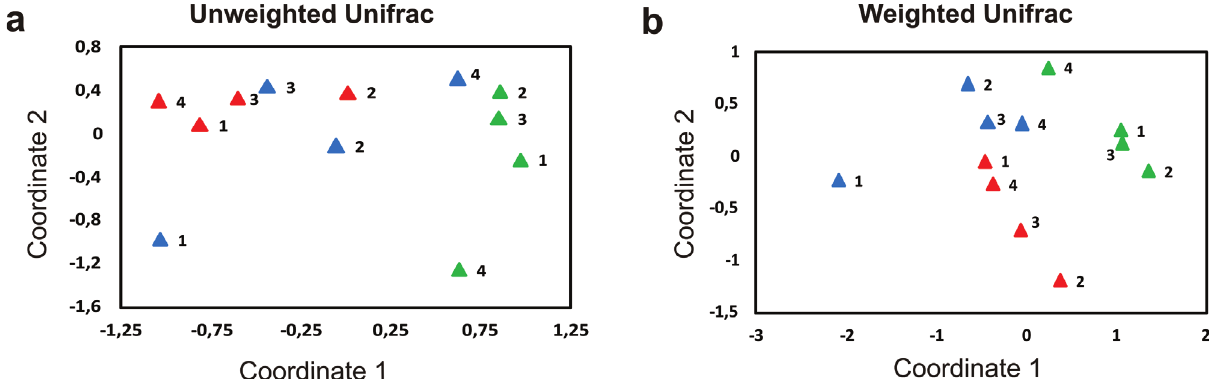
Figure 5 - Non-metric multidimensional scaling (NMDS) clustering using UniFrac distances for bacterial data of coffee genotypes. UniFrac is a distance measure used for comparing biological communities’ information on the relative relatedness of community members by incorporating phylogenetic dis- tances. a) Unweighted (qualitative analysis using presence or absence of organisms), b) Weighted (quantitative analysis accounting for abundance of ob- served organisms). Catuaí ( (cid:2) ), Obatã ( (cid:2) ), Canephora ( (cid:2) ). 1 – Rest, 2 – Blossom, 3 – Early Fruit, 4 – Late